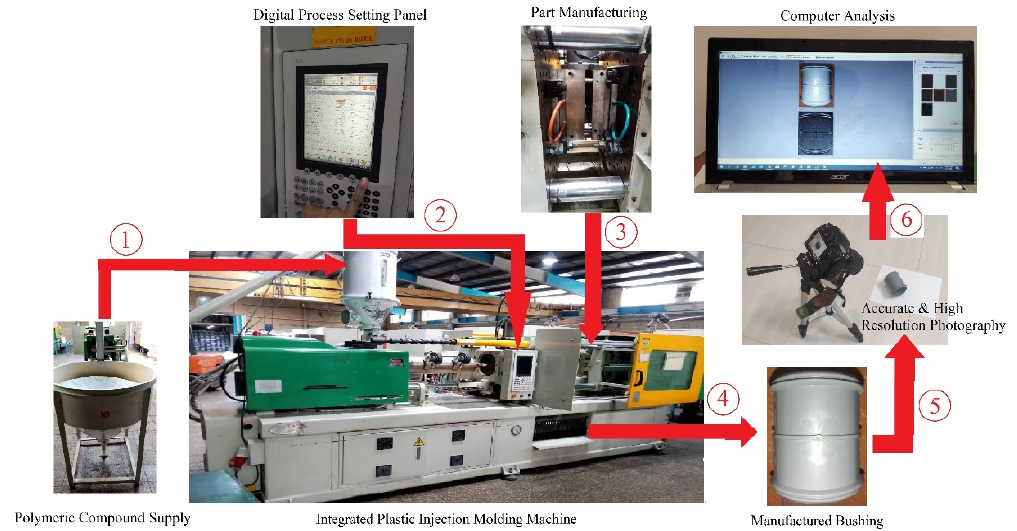
Figure 4. Experimental test procedure.